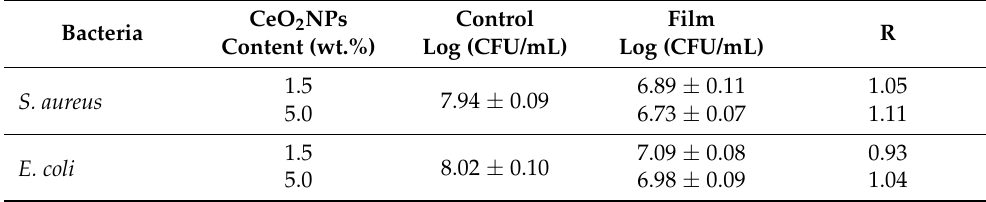
Table 6. Antimicrobial properties of electrospun poly(3-hydroxybutyrate-co-3-hydroxyvalerate) (PHBV) films loaded with cerium oxide nanoparticles (CeO 2 NPs) and hexadecyltrimethylammonium bromide (CTAB) at 24 h exposure against S. aureus and E. coli . CeO 2 NPs Control Bacteria Content (wt.%) Log